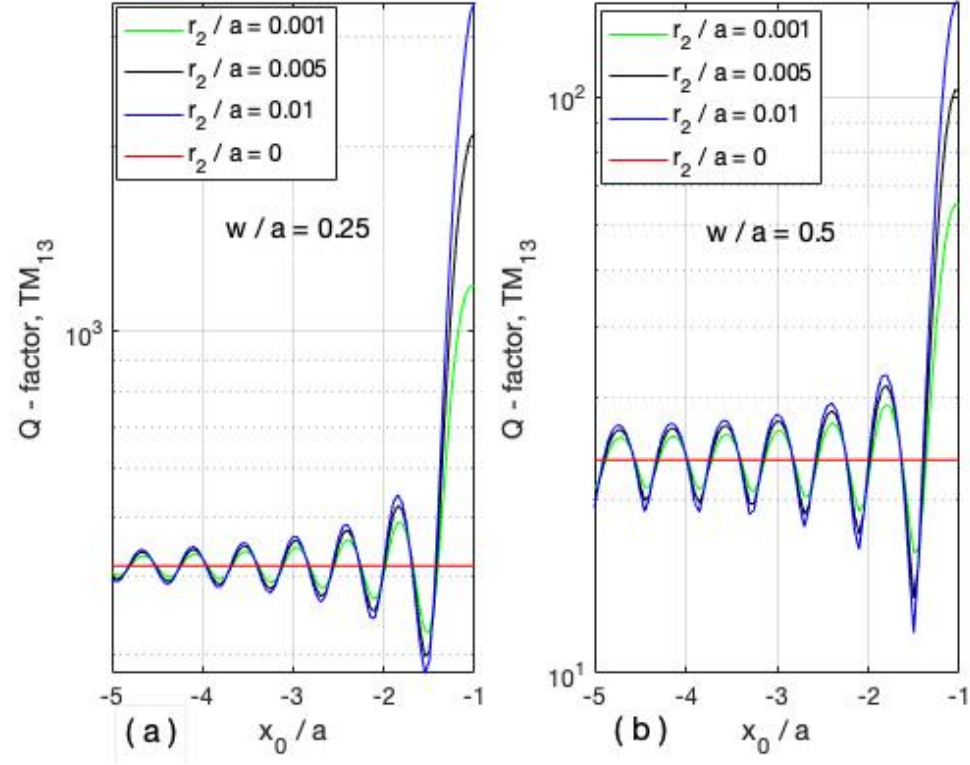
Figure 11. 𝑄 factor of the complex eigenmode 𝑇𝑀 (cid:2869)(cid:2871) versus relative distance 𝑥 (cid:2868) 𝑎⁄ for rectangular Figure 11. Q factor of the complex eigenmode TM 13 versus relative distance x 0 / a for rectangular slotted cavities with wires ( 𝑟 (cid:2870) 𝑎 = 0.001, 0.005, 0.01):⁄ ( a ) 𝑤 𝑎⁄ = 0.25; (𝐛) 𝑤 𝑎⁄ = 0.5 . slotted cavities with wires ( r 2 / a = 0.001, 0.005, 0.01 ) : ( a ) w / a = 0.25; ( b ) w / a = 0.5. Table 5. plex eigenvalues of slotted ( w / a = 0.25, 0.5 ) rectangular cavity in a presence of the